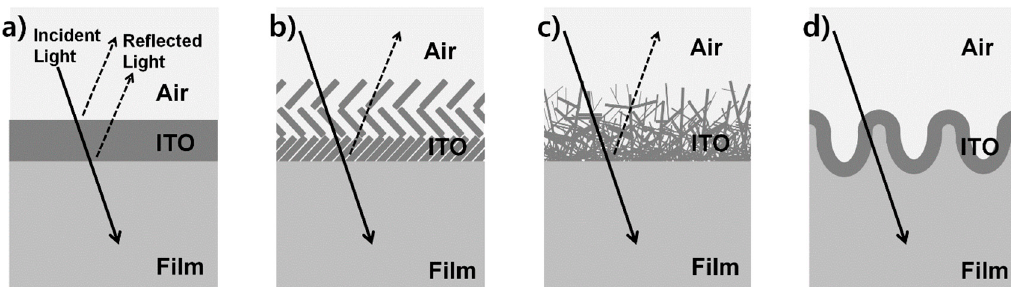
Figure 1. Schematic diagrams showing the structures of the conventional λ /4 antireflection (AR) coating transparent conductive oxide (ITO) film ( a ) and the nano-porous ITO film ( b ) and highly branched ITO nanowire film ( c ) and the new structure for an ideal complex continuous refractive index (CCRI) ITO film designed in this work ( d ).